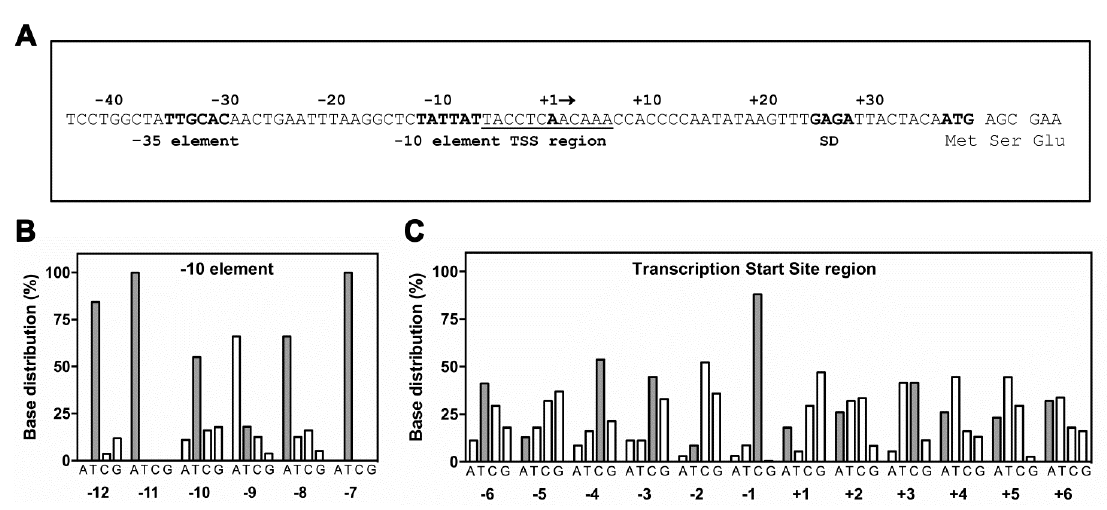
Figure 6. Matching of hns promoter sequence with base distributions for (p)ppGpp-inhibited promoters. The hns promoter hexamers ( − 35 and − 10), Transcription Start Site (TSS) region including the Discriminator, Shine-Dalgarno Sequence (SD) and DNA sequence encoding for the first three amino acids of H-NS are shown ( A ). The hns nucleotide sequence (gray bars) at –10 promoter motif ( B ) and TSS region ( C ) was overlaid with base distribution histograms for ppGpp / DskA inhibited promoters as freely redrawn using data by Sanchez-Vazqueza et al. [11].